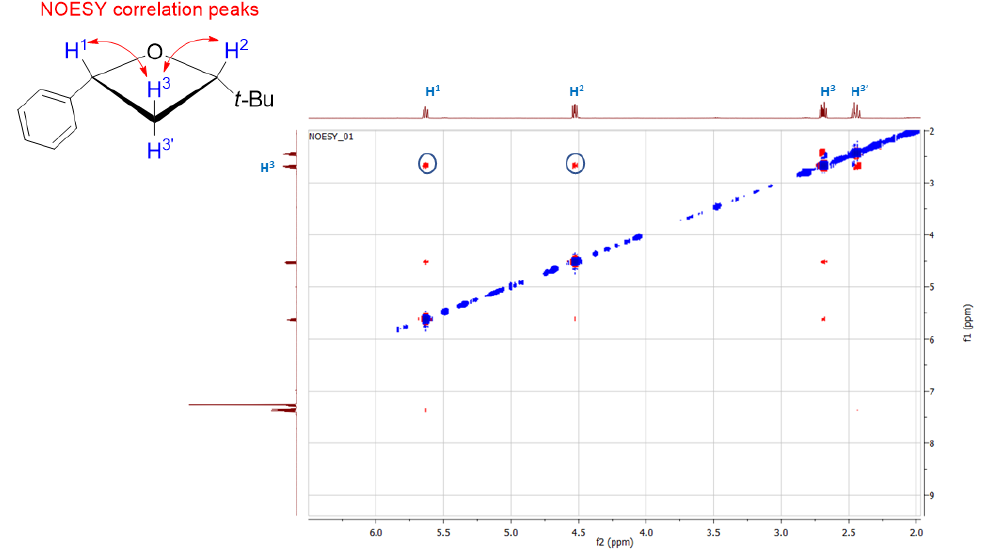
Figure 2. 2D-NOESY NMR spectrum, CDCl 3 , cis- 2-( tert -butyl)-4-phenyloxetane ( 5 ): selected NOE interactions.